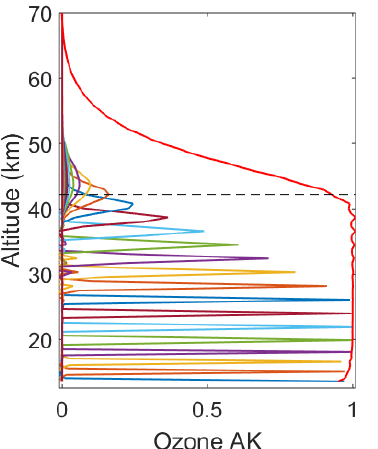
Figure 4. Residuals between the forward model and the measure- ments for the online and off-line channel (blue curves). The red line shows the uncertainty of the